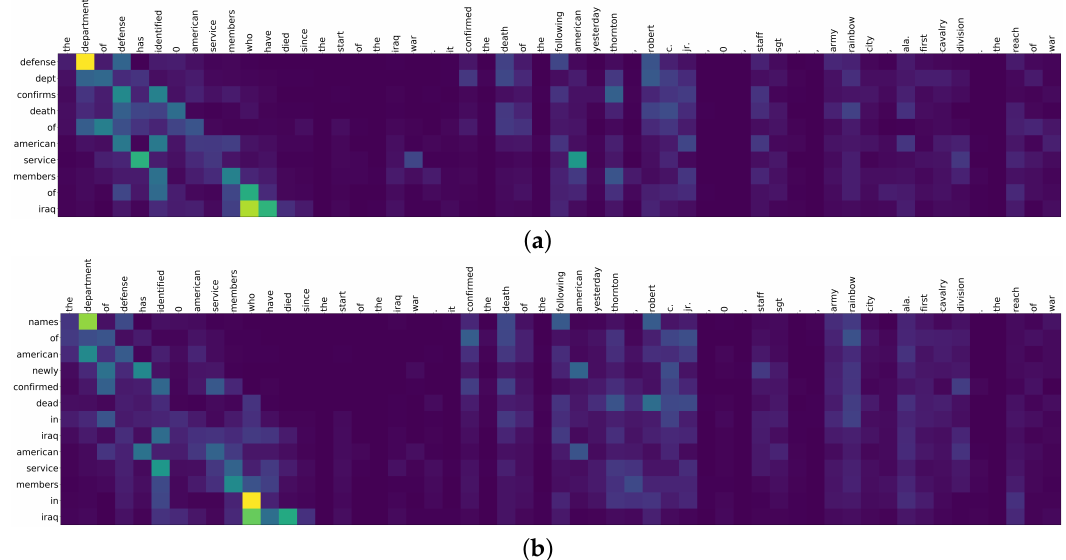
Figure 4. The attention heatmaps of the proposed model and the vanilla attention-based sequence- to-sequence model between a source text and a generated summary. ( a ) A summary by the proposed model; ( b ) a summary by